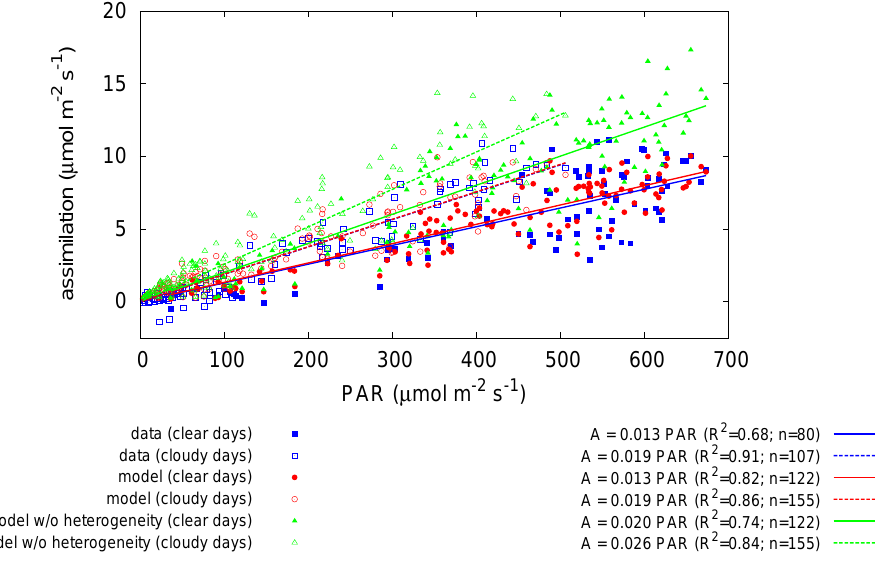
Figure 8. Daily integrated flux of CO 2 assimilation as a function of the daily integrated photosynthetically active radiation (PAR) separated for clear days ( f dif < 0 . 5) and cloudy days ( f dif ≥ 0 . 5). Shown are results from the full heterogeneity simulation and the simulation without heterogeneity in light, as well as the observation-derived CO 2 assimilation flux. Days with fewer than 45 (out of 48) half-hourly observations were omitted. Regression lines (obtained with least-squares linear regression through the origin) are shown for the three data sets as well (full lines corresponding to the clear days, dashed lines to the cloudy